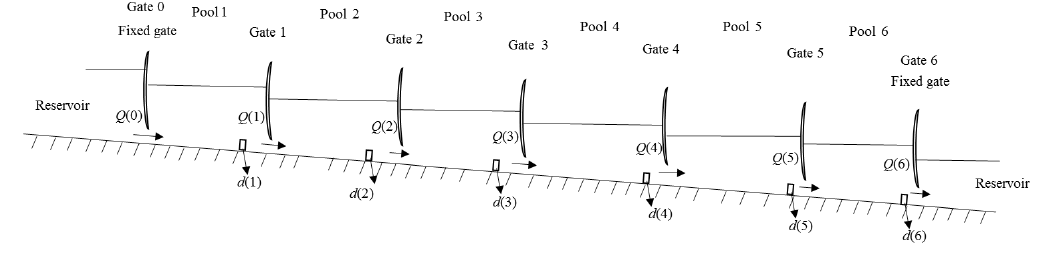
Figure 1. Layout of the studied canal system.